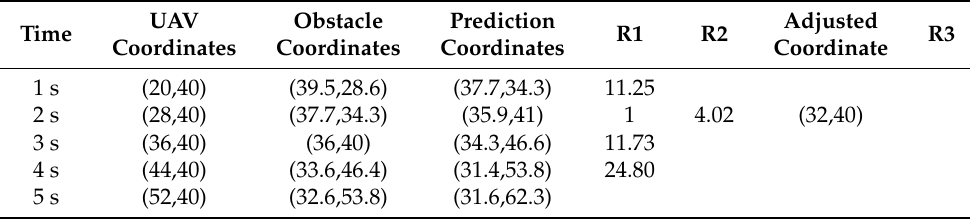
Table 10. Coordinate information of the local path adjustment in Figure